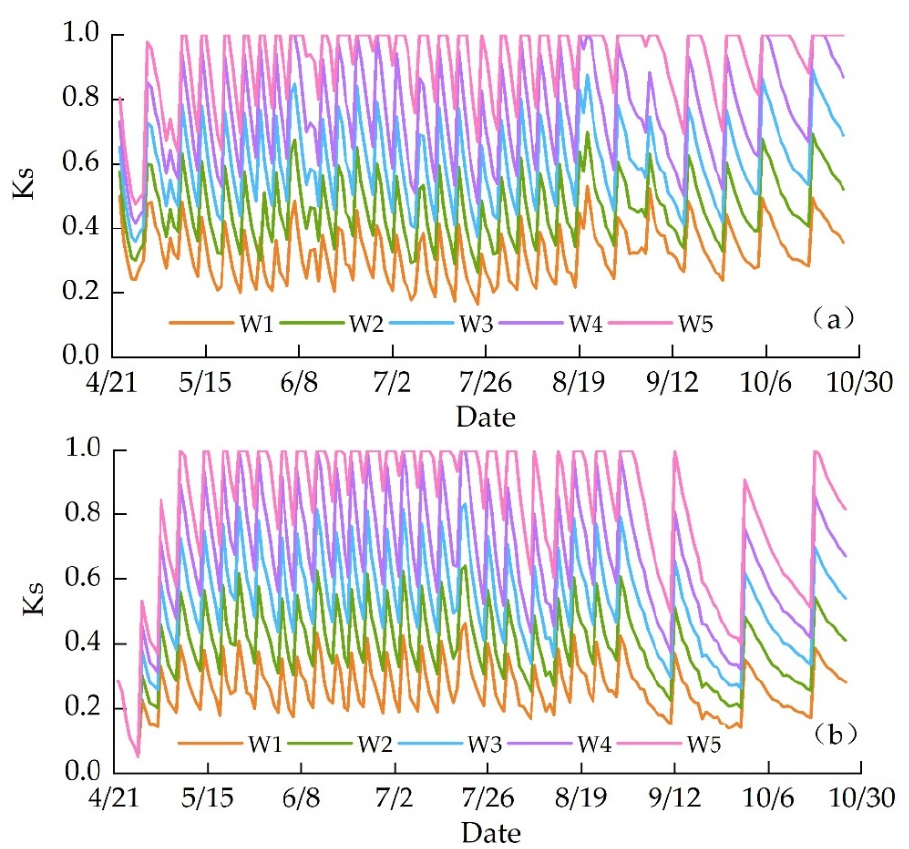
Figure 6. Seasonal changes in soil water stress coefficient (Ks) in the DCHD-cultivated apple orchard with drip irrigation in ( a ) 2019 and ( b ) 2020.